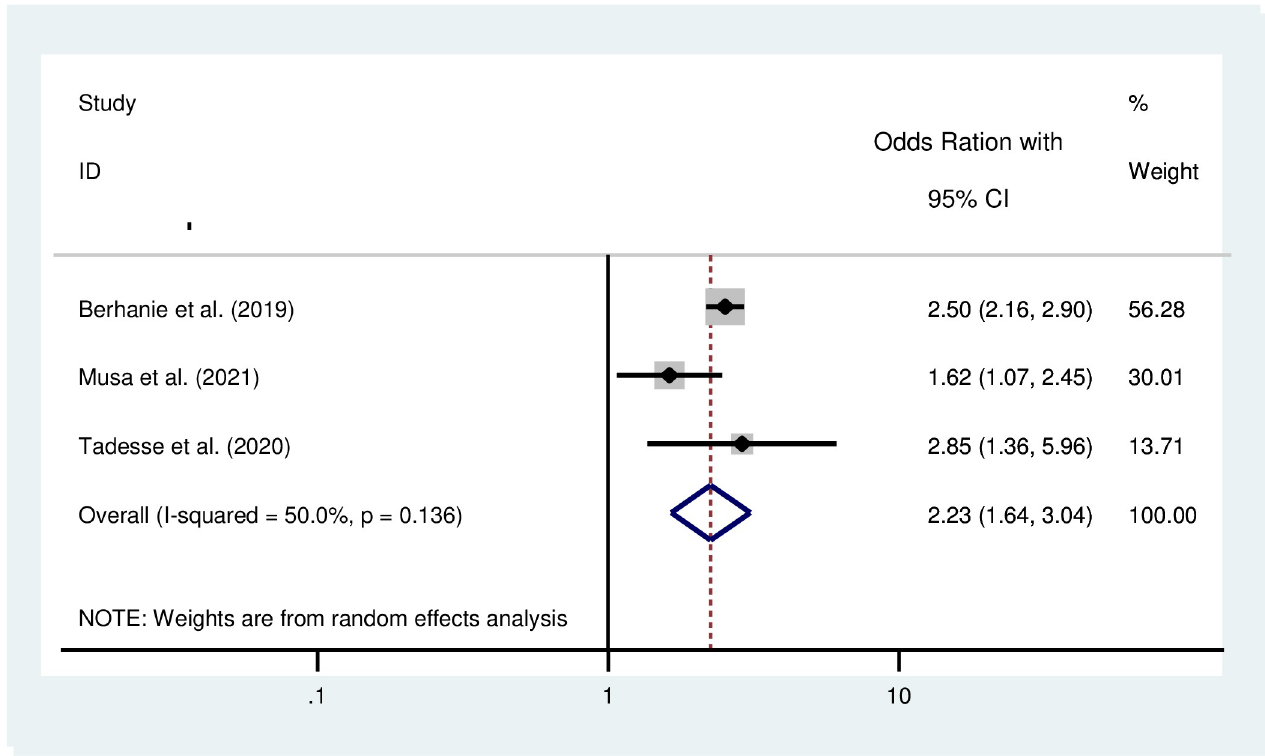
Fig 5. Forest plot for the pooled association between intimate partner violence during pregnancy and preterm birth in Ethiopia.